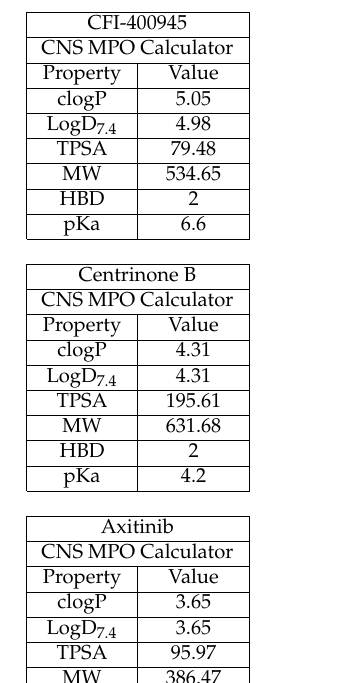
Table 2. ( A ) Physical multi-property analysis for each inhibitor, calculated using ACD Percepta 2016 (Build 2911). ( B ) LogBB values, obtained using ACD Labs Percepta software v16, for PKIs. Green—highest logBB; Red—lowest